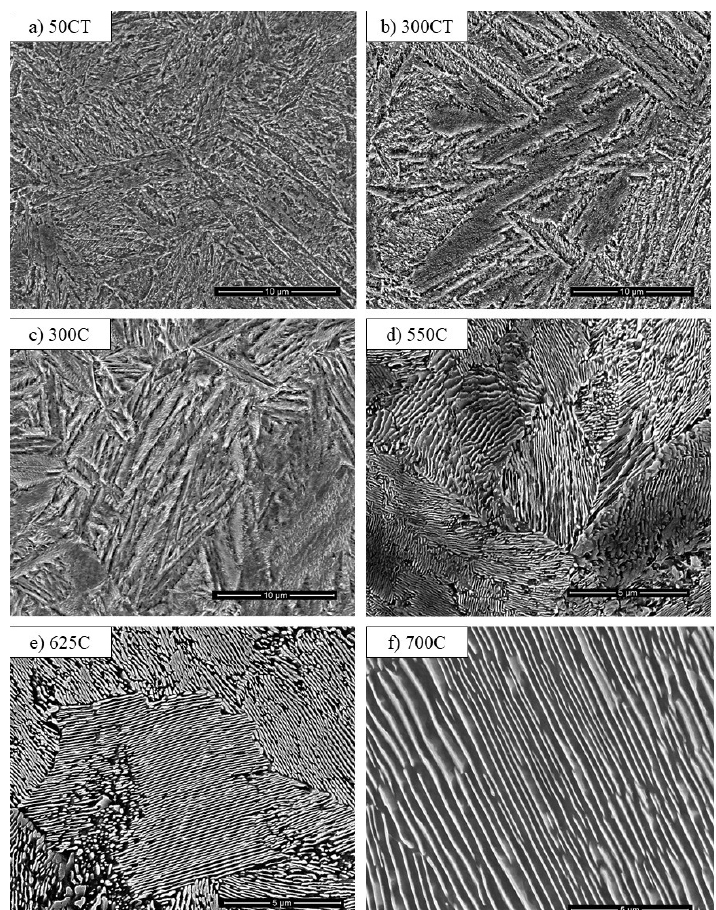
Figure 4. SEM micrographs of